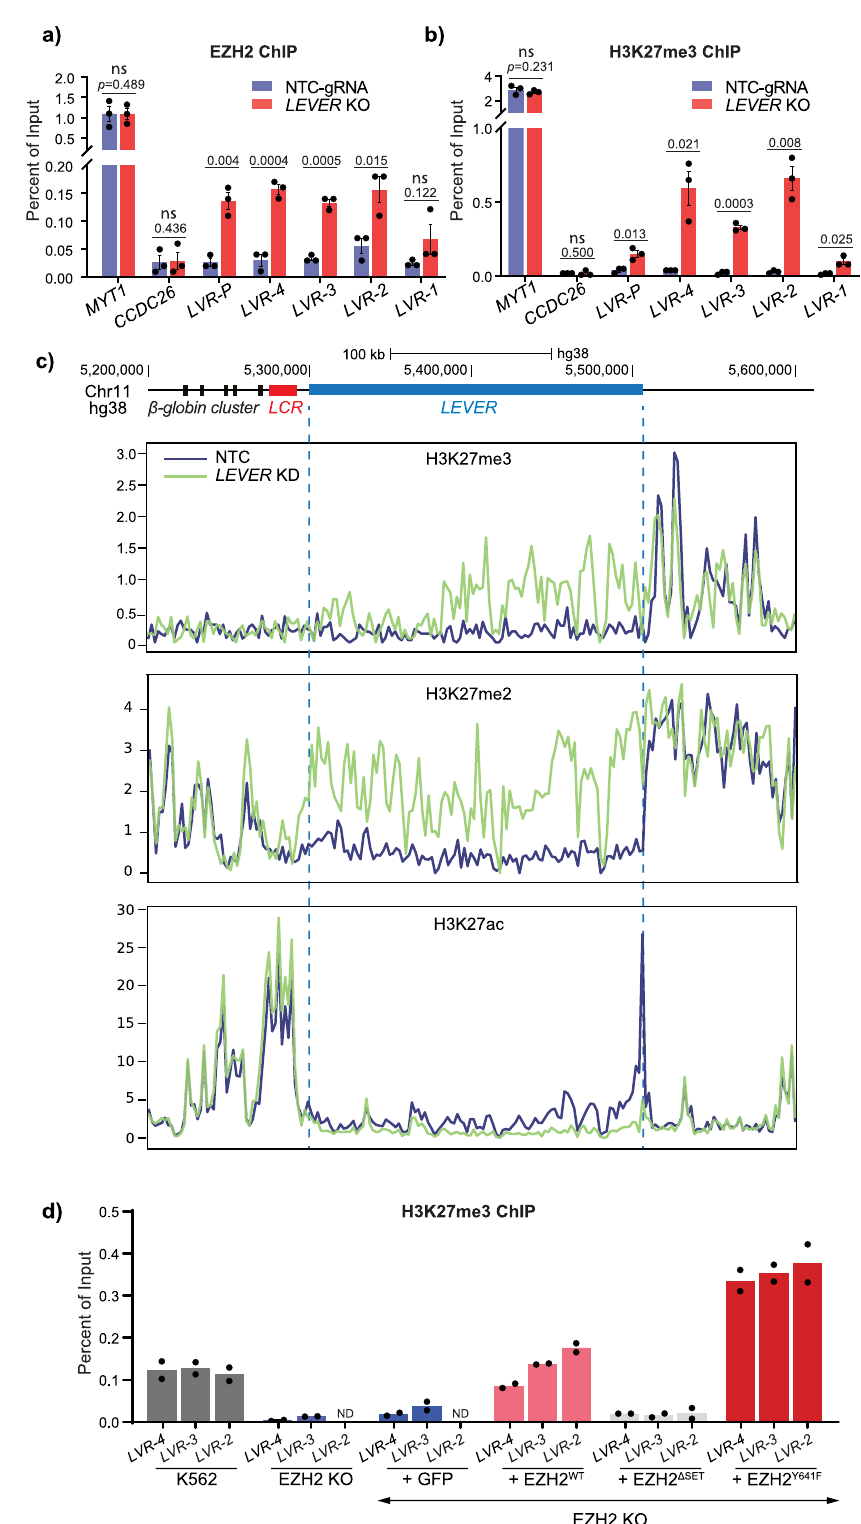
Fig. 4 LEVER RNA sequesters EZH2 and blocks histone H3K27 methylation at the LEVER locus in cis. a , b EZH2 ( a ) or H3K27me3 ( b ) chromatin occupation at selected regions within the LEVER locus. MYT1 and CCDC26 serve as ChIP positive and negative controls, respectively. LVR-P primer pair is designed at the LEVER promoter region. Data from n = 3 biological replicates are shown. Error bars represent SEM. Statistical difference was calculated using Welch ’ s one-tailed t -test. ns, not signi fi cant. c H3K27me3, H3K27me2, and H3K27ac ChIP-seq pro fi ling at LEVER and its neighboring locus in dox- inducible non-targeting control (NTC) or LEVER knock-down ( LEVER KD) K562 cells treated with dox for 28 days. d H3K27me3 ChIP-qPCR of EZH2-KO and rescued cells as in Fig. 3a, b at LVR-4, LVR-3, and LVR-2